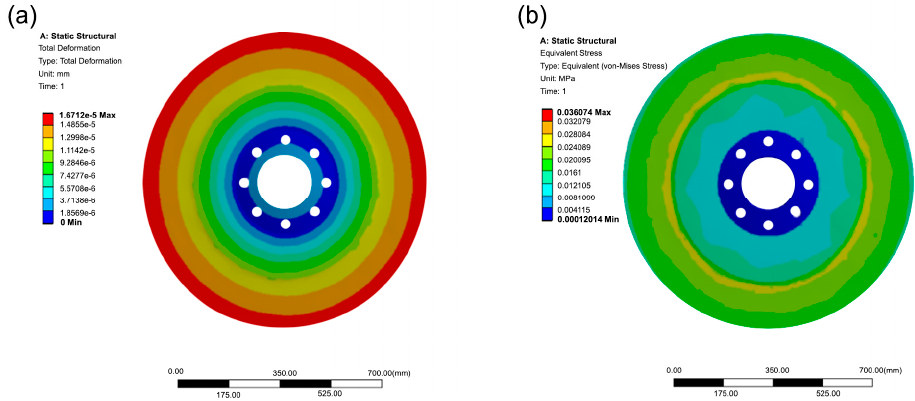
Figure 2. Static structural simulation of brake disc ( a ) total distortion, ( b ) equivalent stress.